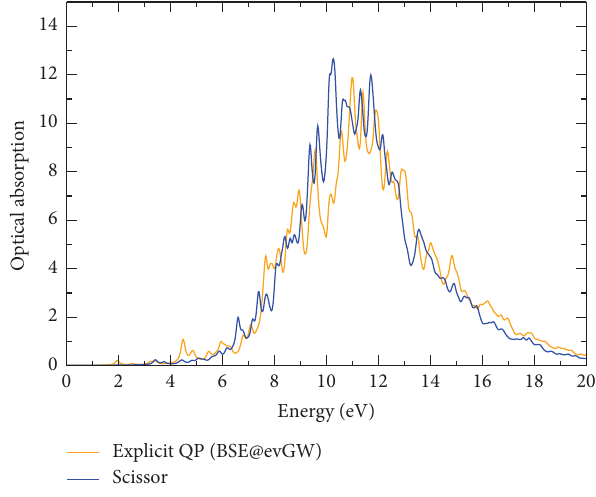
Scissor2 Explicit QP (BSE@evGW) Figure 5: Te absorption (arbitrary unit) of type II o-BC the BSE and scissor operator after renormalization of the valence band and conduction band in the polarization direction xyz (/or